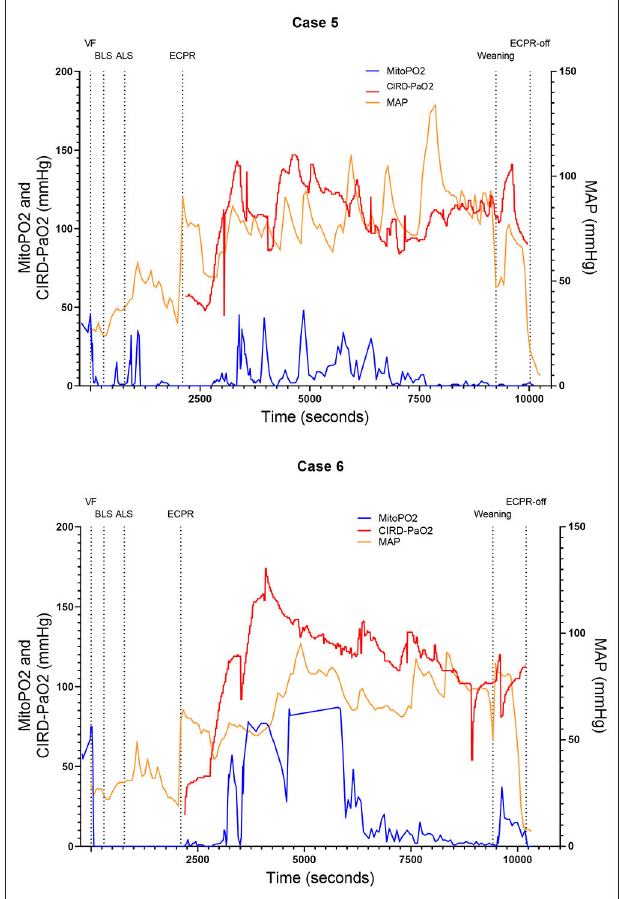
FIGURE 4 | Course of mitoPO 2 , CIRD-PaO 2 , and MAP for experimental tests case 5 and 6. Course of mitoPO 2 and CIRD-PaO 2 in mmHg levels at the left Y -axis and course of MAP in mmHg levels at the right Y -axis all over time in seconds. Case 5 at the above panel and case 6 at the below panel. VF, ventricular fibrillation; ECPR, extracorporeal cardiopulmonary resuscitation; CIRD-PaO 2 , arterial partial oxygen pressure measured by controlled integrated resuscitation device; mitoPO 2 , mitochondrial partial oxygen pressure.